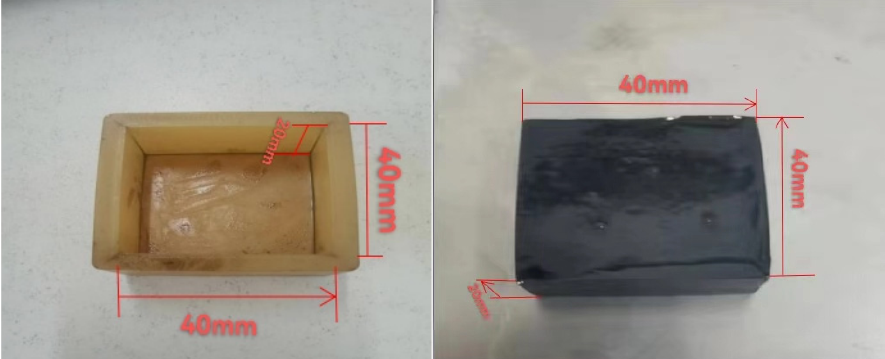
Figure 8. Self-made silicone mold and demolding asphalt test